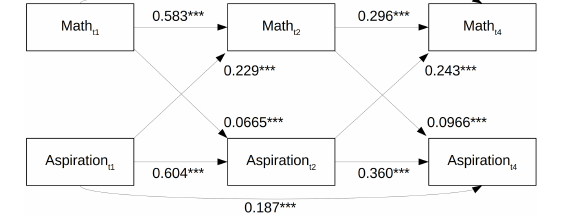
FIGURE4 Path coefficients for the CLPMSource: NEPS SC2, imputed data. Control variables: gender, age, income, parental education, migration status, number of siblings, place of residence, single parents, dyscalculia. Standard errors clustered by school. *** p <